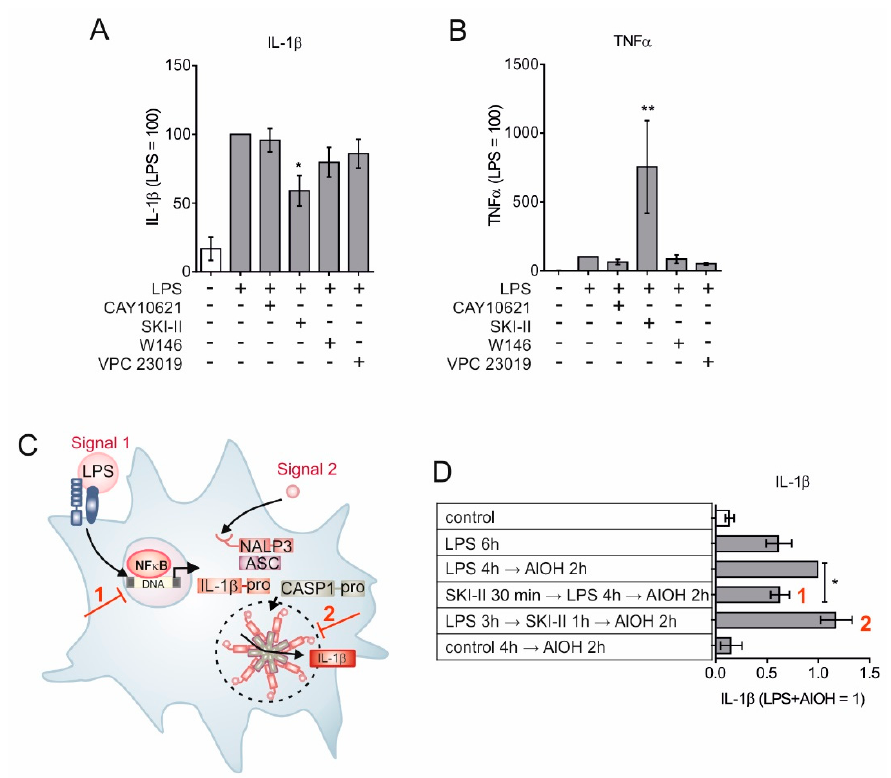
Figure 1. Sphingosine kinases are involved in “signal 1” of the NLRP3 inflammasome. Primary human macrophages were preincubated for 30 min with 5 µM CAY10621, 10 µM SKI-II, and 1 µM each of W146 and VPC 23019. Cells were then stimulated with 10 ng/mL LPS with or without inhibitors for 2 h. Agonists and inhibitors were washed off and cells were further cultivated in fresh media for another 24 h. Cell free supernatants were analyzed for ( A ) IL-1 β and ( B ) TNF- α by cytometric bead array (CBA). Data are means ± SEM, n = 6 donors. ( C ) Schematic depiction of two signals for NLRP3 inflammasome activation. Red numbers indicate intervention with signal 1 and signal 2 respectively. ( D ) Macrophages were left untreated, treated with 100 ng/mL LPS, 1 µg/mL AlOH and 10 µM SKI-II for 1–6 h in a permutation and combination depicted in the table and IL-1 β levels were measured in cell-free supernatant using CBA. Red numbers indicated interventions as depicted in C . Data are means ± SEM, n ≥ 10 donors. * p < 0.05; ** p < 0.001; p values were calculated using one-sample t test ( A , C , D ).